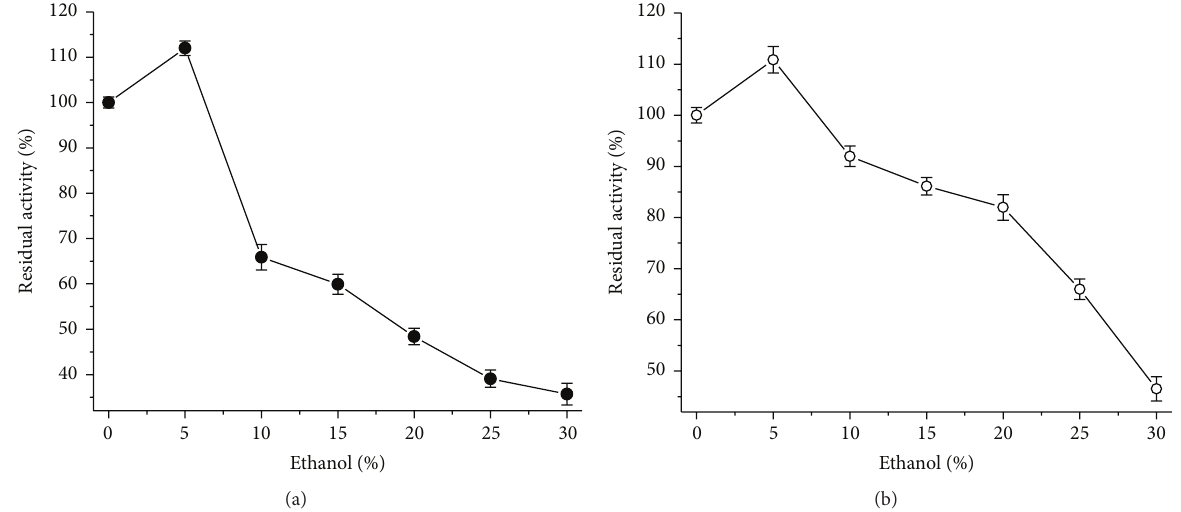
Figure 3: Effect of ethanol on amylase activity. (a) L. ramosa ; (b) T. aurantiacus (each data point was the average of two replicate determinations, and the error bars show the data